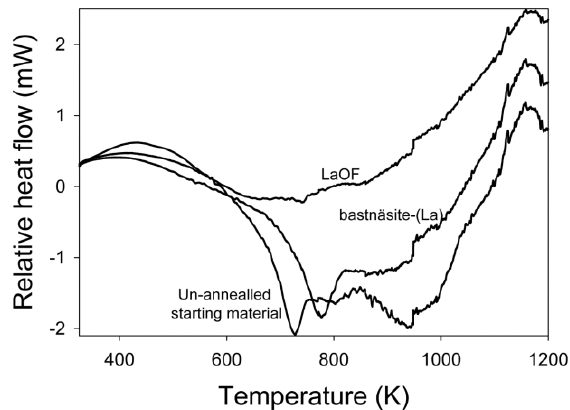
Figure 4. Differential scanning calorimetry (DSC) curves for annealed bastnäsite-(La), unannealed starting material, and LaOF from 325 K to 1223 K. Endotherms can be seen on both the annealed bastnäsite-(La), and unannealed starting material curves from the range near 598 K to 773 K, indicating the decomposition reaction. The LaOF curve does not exhibit this, since it did not decompose. Exotherms at 948 K and endotherms at 1123 K are evident on all three curves, indicating phase transformations.